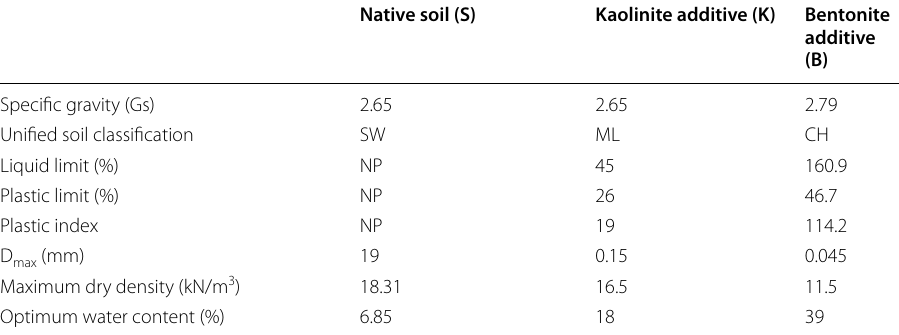
Table 1 The specifications of native soil (S) and fine additives (kaolinite and bentonite)